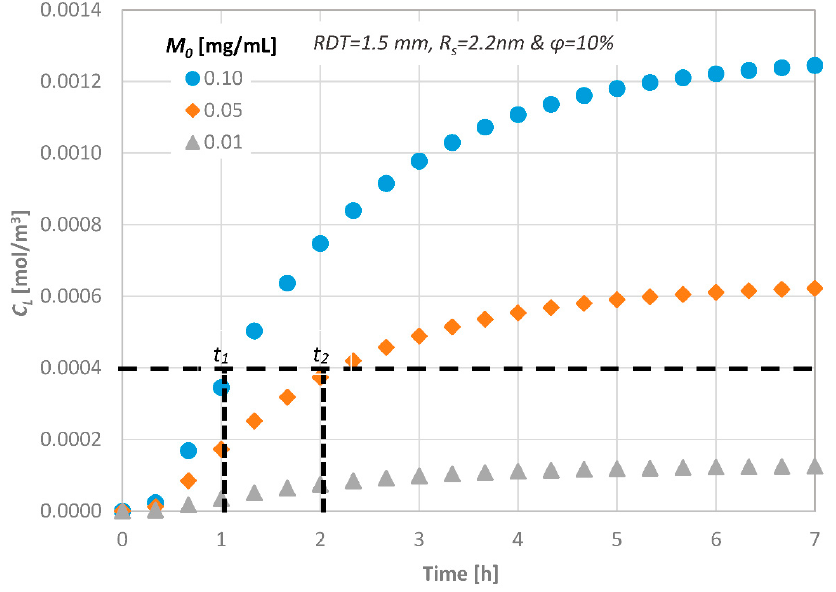
Figure 13. Effect of the initial substance concentration on the diffusion characteristics.